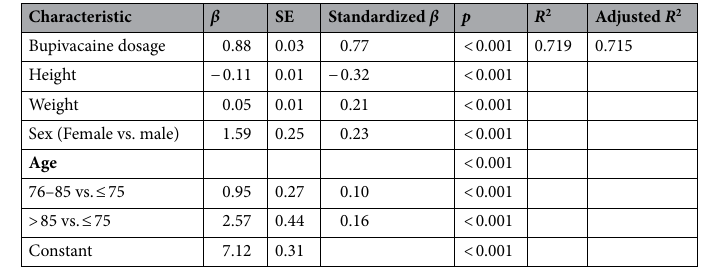
Characteristic β SE Standardized β